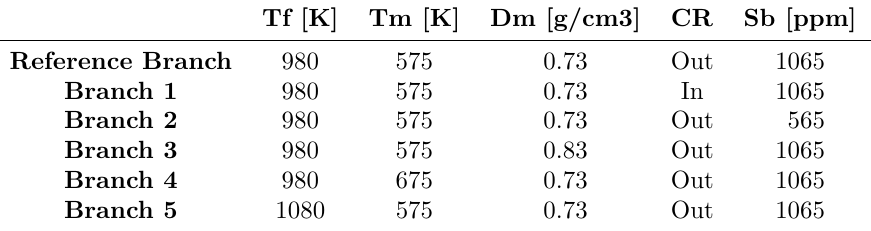
Table 2. SCALE Branch structure.